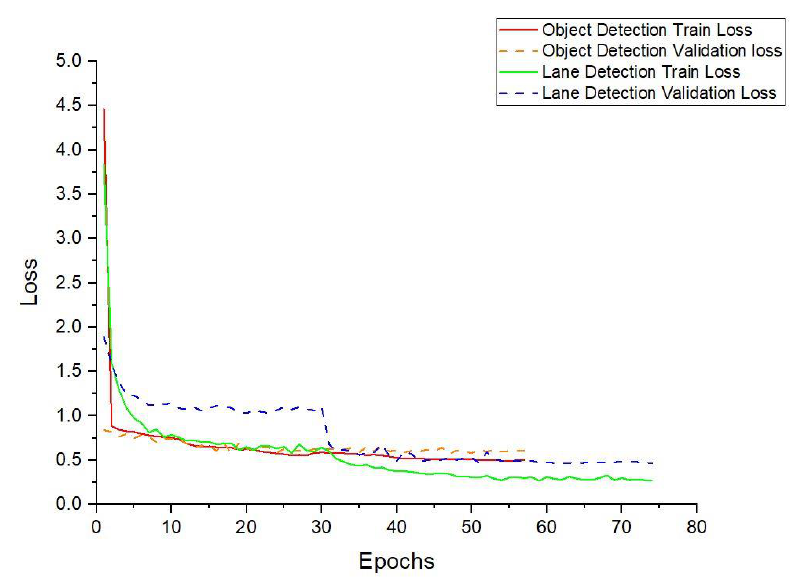
Figure 14. Model loss function graph.